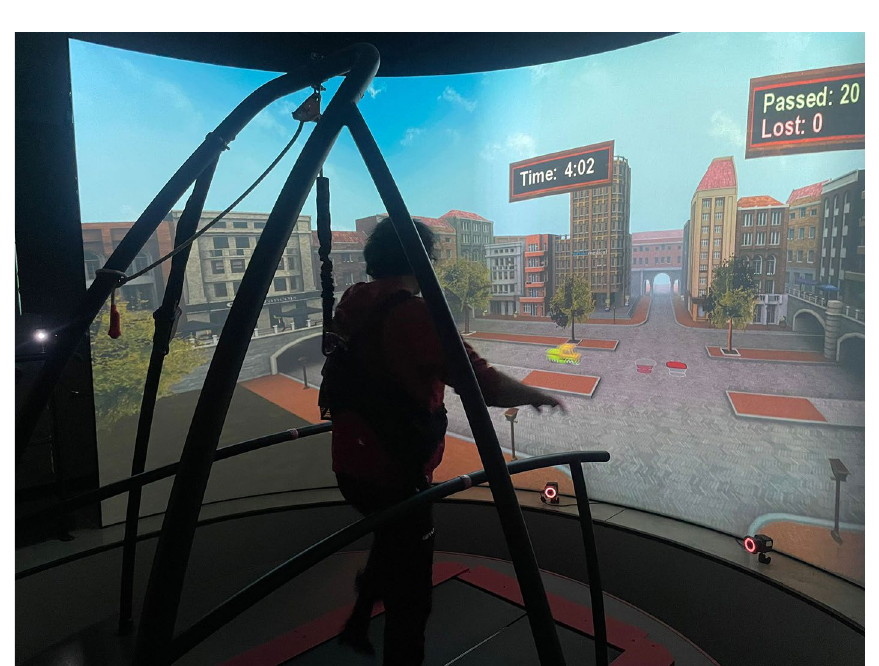
Figure 3. CAREN training: Traffic Jam